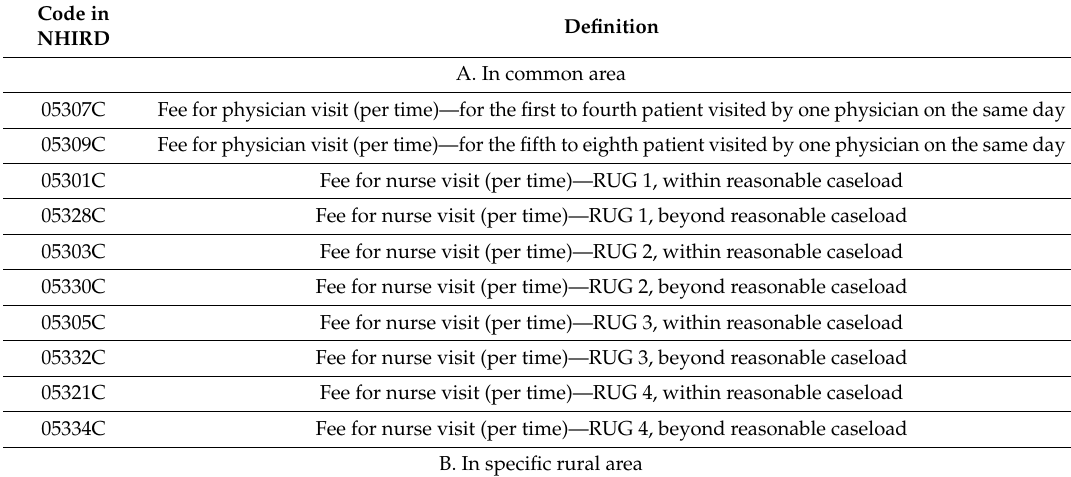
Table A2. List of administrative claim codes for home healthcare in the National Health Insurance Research Database